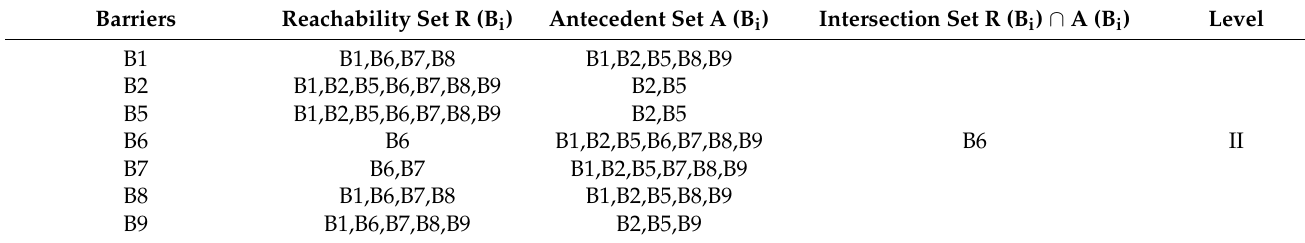
Table A2. Level partition iteration II.